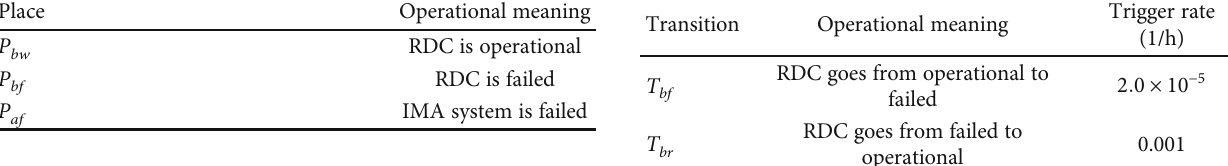
Table 5: Places in GSPN model for RDC and IMA system. Place